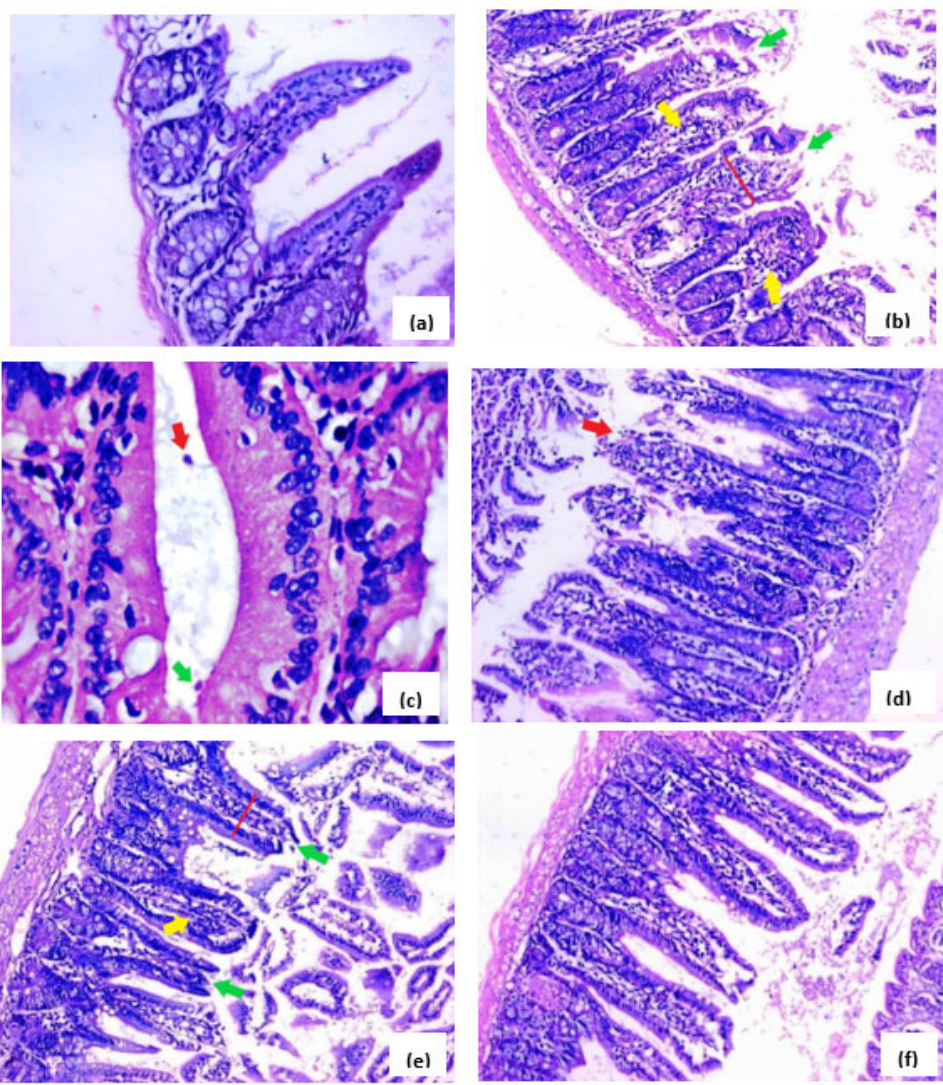
Figure 3. Histological photomicrographs of small intestinal sections (stained with H&E, unless mentioned otherwise, 200 × ). ( a ) Sections from normal mice (GI) displayed the normal structure of the villi with a preserved brush border and normal pattern of mucin secretion. ( b ) Sections from infected mice (GII) revealed a significant broadening of villi (red line), dense infiltration by mononuclear inflammatory cells (yellow arrows), and villous tip-region degeneration (green arrows). ( c ) Sections from infected mice (GII) revealed numerous adherent (green arrow) and separate cryptosporidium oocysts (red arrow, H&E stain, stained purple, 4–6 µ m in diameter, 1000 × ). ( d ) Sections from infected mice (GIII) treated with the reference drug (NTZ) demonstrated mild villi broadening with focal tip-region degeneration and mild mononuclear inflammatory cell infiltration. ( e ) Sections from infected mice (GIV) treated with H. hemistemon extract (100 mg/kg) demonstrated moderate villous broadening (red line), infiltration by mononuclear inflammatory cells (yellow arrow), and focal degeneration of the villous tip regions (green arrow). ( f ) Sections from infected mice (GV) treated with H. hemistemon extract (200 mg/kg) showed a retained villous architecture, such as the recovery of an almost normal villous pattern with the occasional appearance of inflammatory